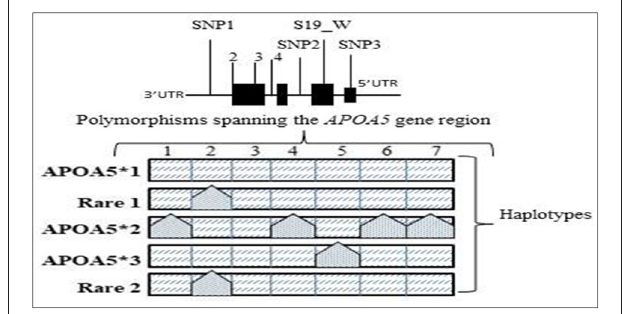
FIGURE 2 | The APOA5 variants and common haplotypes: specific APOA5 polymorphisms found on the genetic interval contributing to the five major haplotypes seen in various populations